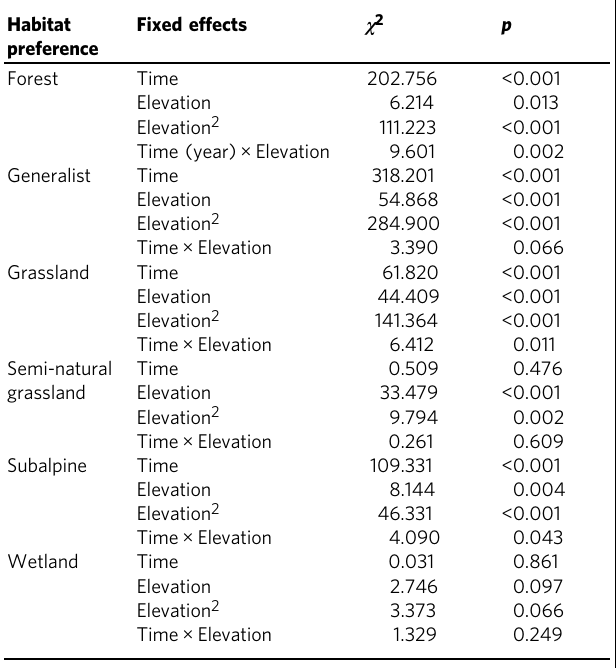
Table 2 Effect of time (linear), elevation (linear and quadratic terms) and their interaction on population size for each habitat preference category,